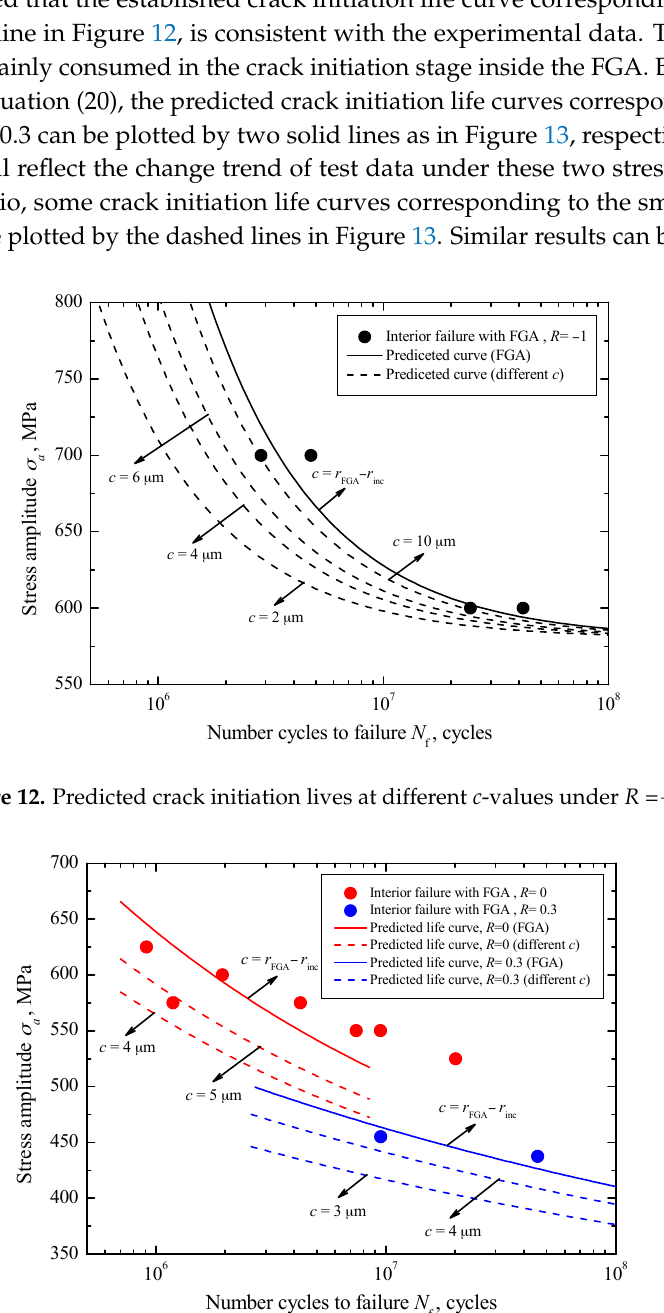
Figure 13. Predicted crack initiation lives at different c -values under R = 0 and 0.3.